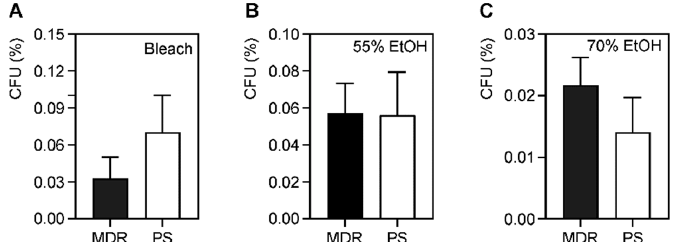
Figure 2. Comparison of survival of microbicide exposure of multidrug-resistant and pan-suscepti- ble strains. Average percent survival of five MDR and five PS planktonic A. baumannii strains following exposure to ( A ) 4 min of bleach, ( B ) 1 min of 55% ethanol, and ( C ) 1 min of 70% ethanol. The bars show mean survival and error bars represent standard deviation. A p -value of ≤ 0.05 was considered significant. No significant differences were observed.